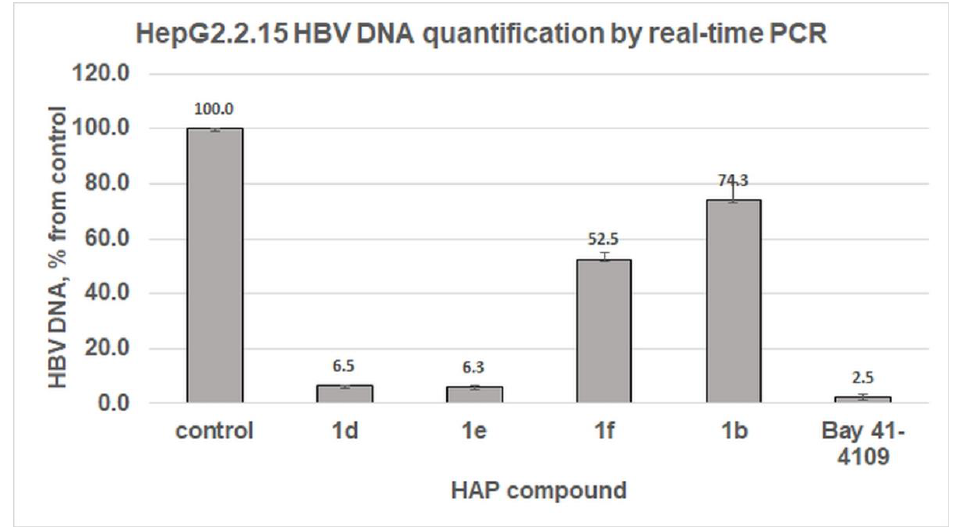
Figure 8. Quantification of HBV DNA in HepG2.2.15 HBV-producing cells treated with HAP com- pounds. HepG2.2.15 cells were cultured in the presence of the studied HAP compounds in 24-well plates for six days: comp. 1d , 1e , 1f (20 μM), and comp. 1b , Bay 41- 4109 (10 μM). After incubation the cell medium was collected, the virus protected HBV DNA was isolated and quantified by real-time PCR analysis. Untreated cells were used as a control (100%); error bars represent the standard deviation of three repeats.